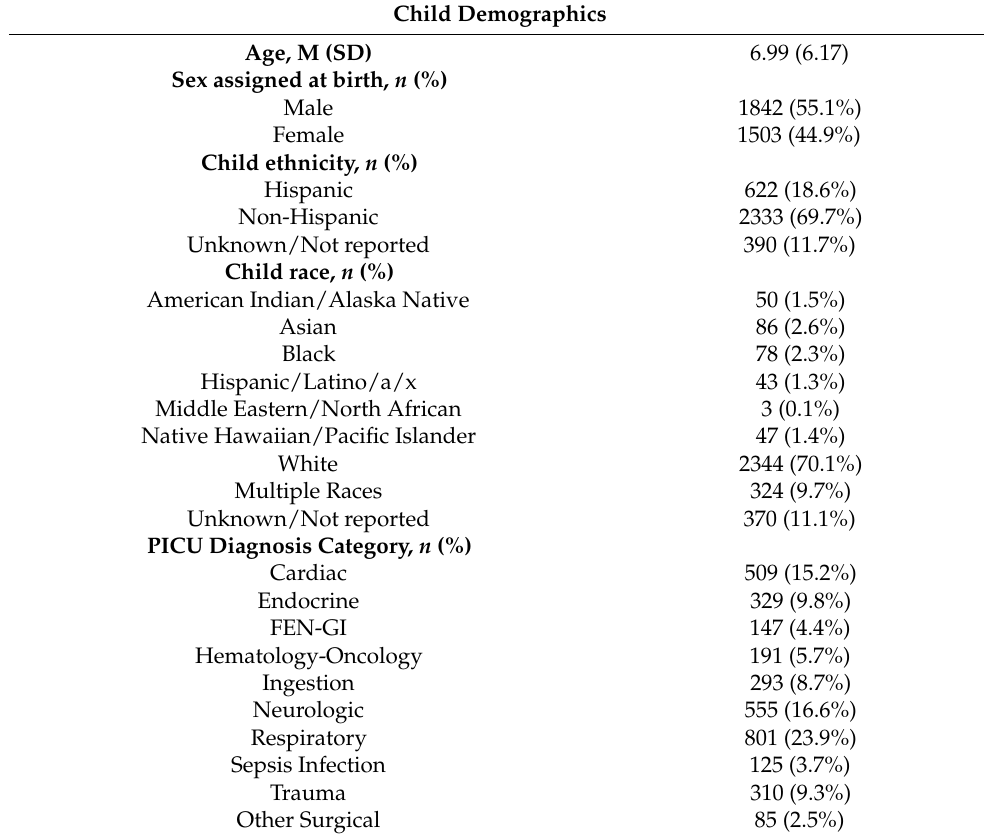
Table 1. Demographic and clinical characteristics of the sample n =